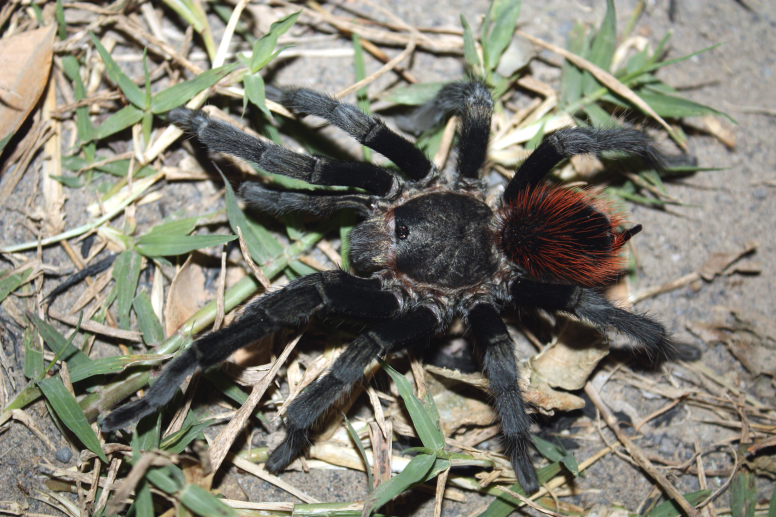
Brachypelma
kahlenbergi Rudloff, 2008 male from near Veracruz, Veracruz state, Mexico. Photo: Stuart J. Longhorn.